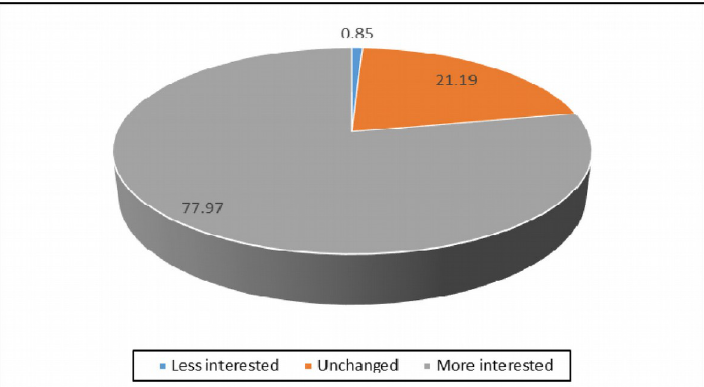
Figure 2. Students’ Interests in Engineering Before and After the Program